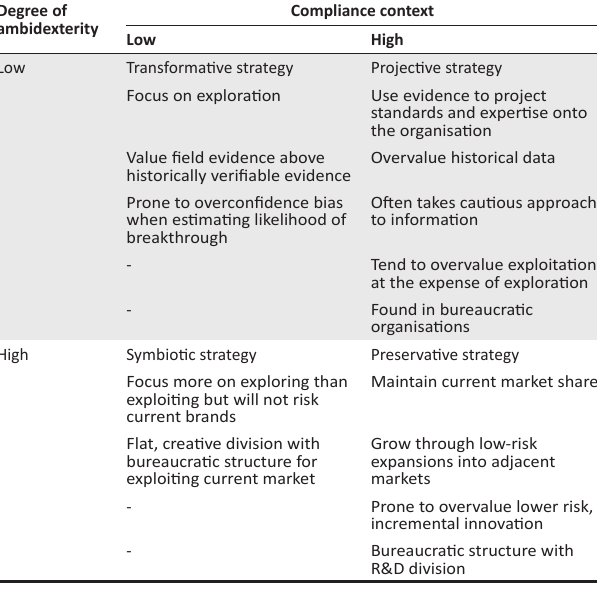
TABLE 1: Ambidexterity